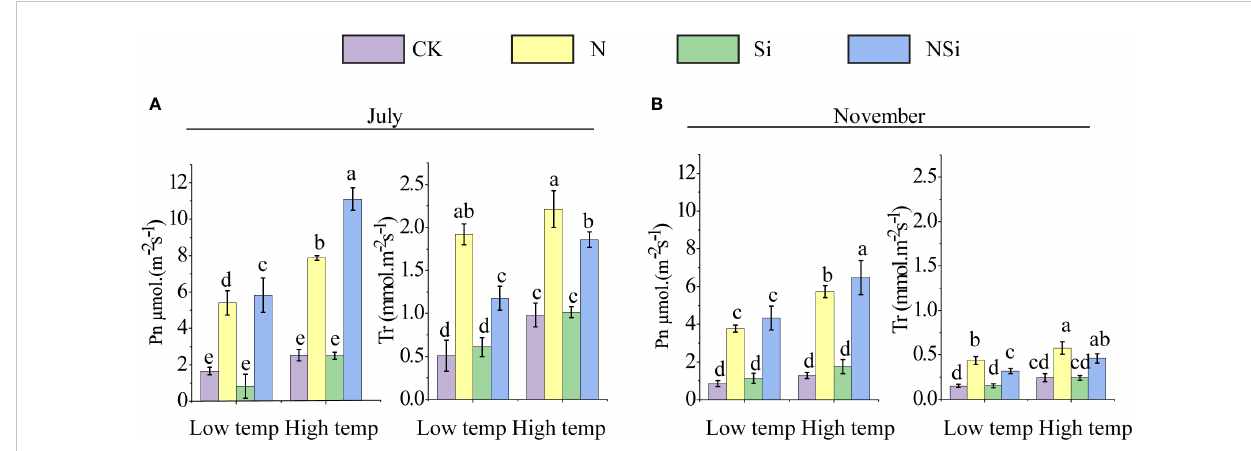
FIGURE 3 (A) photosynthesis and (B) transpiration of Moso bamboo leaves at low and high temperature in July and September. CK, N, Si, and NSi represent the level of fertilization at 0 N 0 Si kg/hm 2 , N157.5 kg/hm 2 , Si 315 kg/hm 2 , N157.5 kg/hm 2 and Si 315 kg/hm 2 , respectively. Error bars represent the standard error of the means. Different letters indicate signi fi cant differences among the treatments of different fertilization at 0.05 level, respectively.